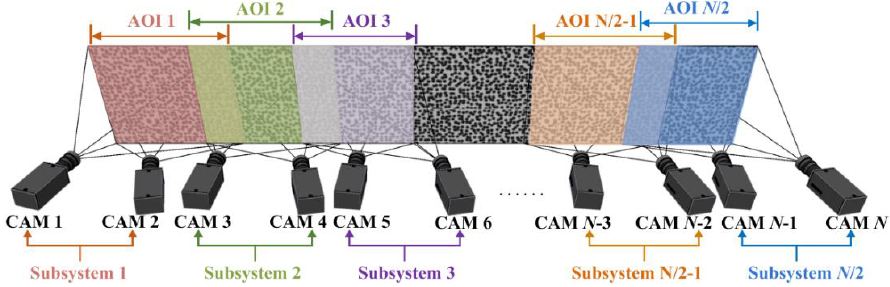
Figure 6. First form of camera arrangement for continuous-view MC-DIC